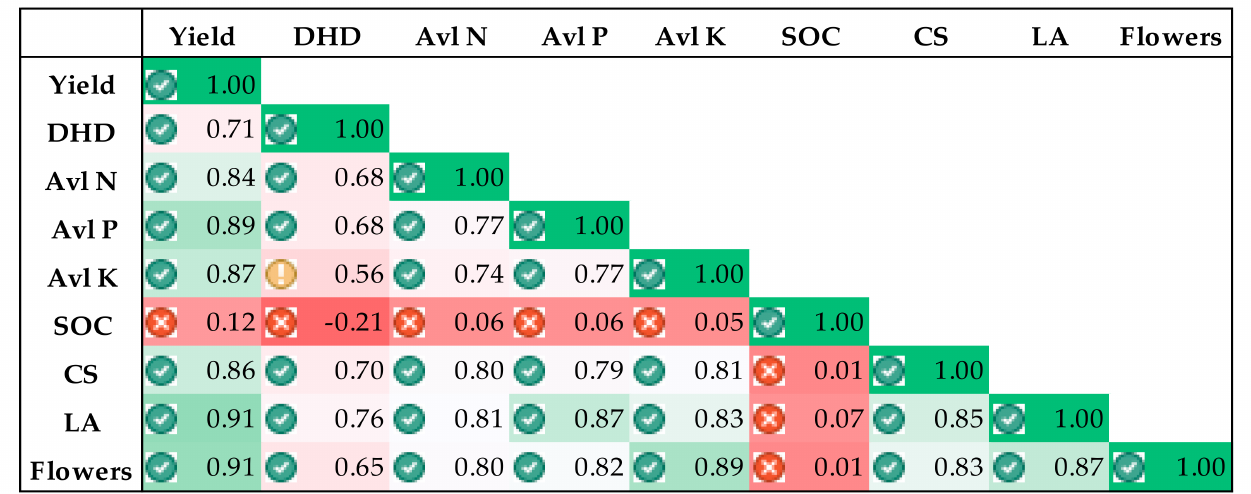
Figure 3. Pearson’s correlation of plant growth response, fruit yield, and soil properties, as augmented by management practices ( p < 0.05, n = 76). DHD (dehydrogenase); Avl N (available nitrogen); Avl P (available phosphorus); Avl K (available potassium); SOC (soil organic carbon); LA (leaf area); CS (canopy spread). strong positive correlation; negative or no correlation; weak positive correlation.